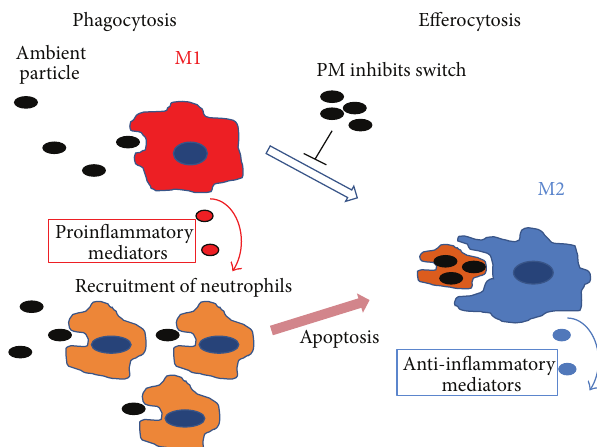
Figure 3: The impact of PM exposure on alveolar macrophage phenotype. PM exposure stimulates macrophages (predominantly M1 phenotype) to produce proinflammatory mediators that attract other immune cells such as neutrophils into the airspaces. Fol- lowing phagocytosis of the PM, these cells undergo apoptosis and are removed by M2 macrophages, which also produce anti- inflammatory mediators that are pivotal for resolution of the inflammatory response induced by the PM exposure. Persistent inflammation in the lung induced by PM exposure may be due to PM that blocks macrophage switching (M1 to M2), compromising